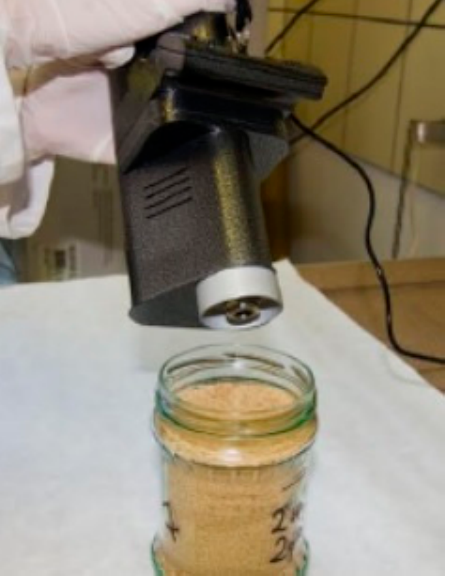
Figure 2. Photo of the sand jar showing the location of the MO-2M detector inlet nozzle.